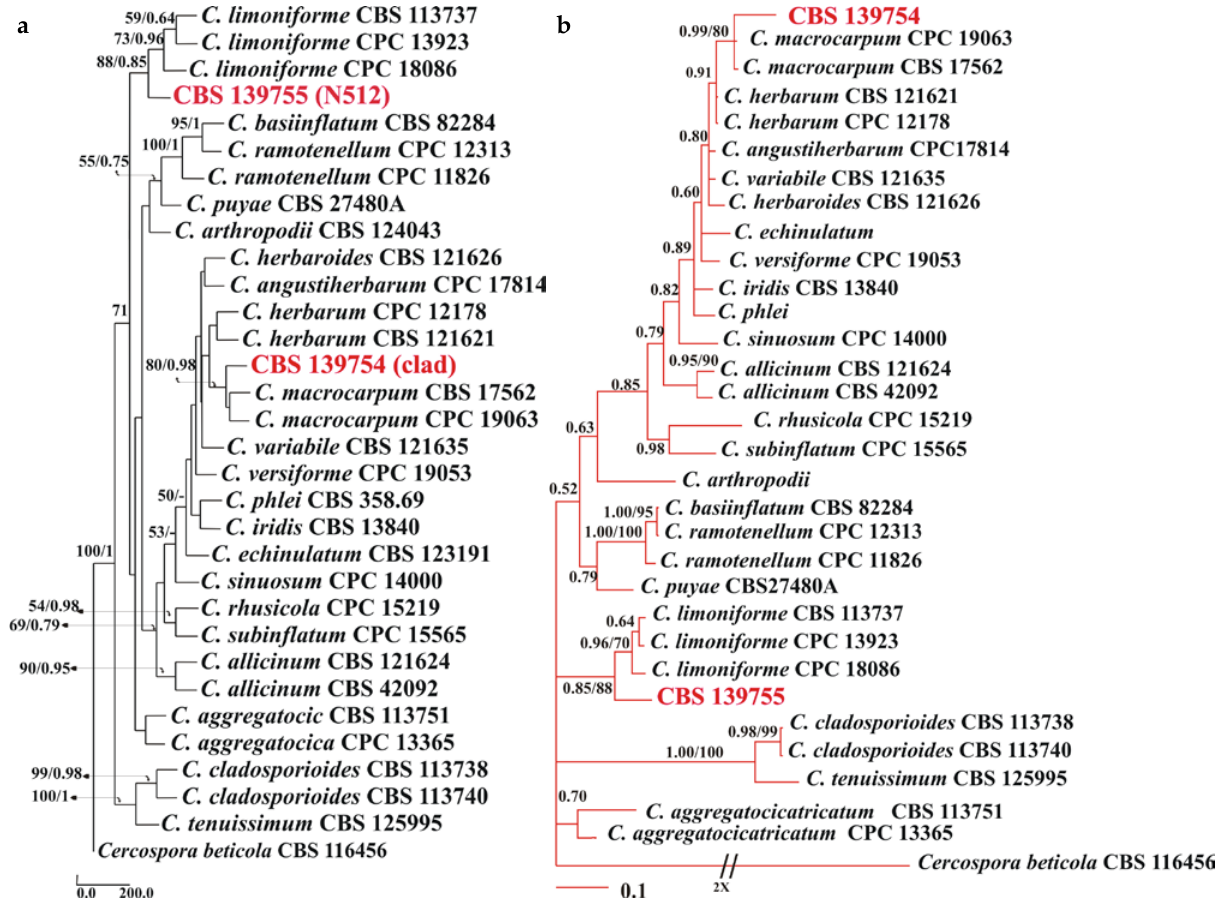
Figure 4. Phylogram generated from Maximum Parsimony (a) and Bayesian analysis (b) based on Tef1 sequences of select- ed Cladosporium species from NCBI and our new isolates. Maximum Parsimony Bootstrap (MPB) support values greater than 50% and Bayesian Posterior Probabilities (PP) greater than 0.75 are indicated above the nodes of each tree. The isolates obtained in this study are shown in bold and red. The scale bar represents the expected number of changes per site. The tree was rooted to C. tenuissimum CBS 125995, C. cladosporioides CBS 113738 and CBS 113740